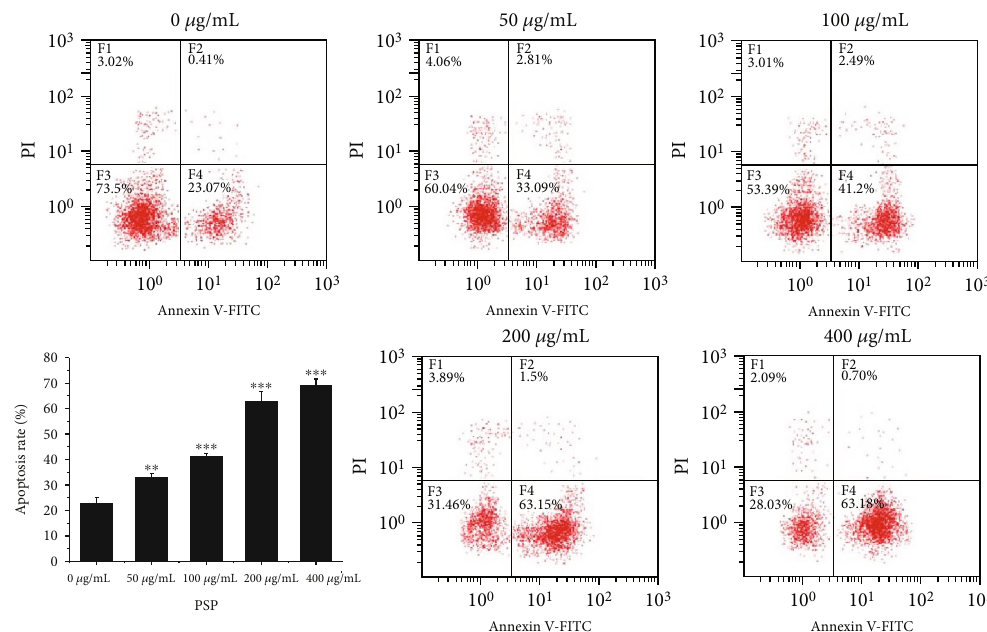
Figure 3: Flow cytometry used to detect apoptosis of Eca109 cells. Compared with the control group, ∗ p < 0 : 05 , ∗∗ p < 0 : 01 , and ∗∗∗ p < 0 : 001 .